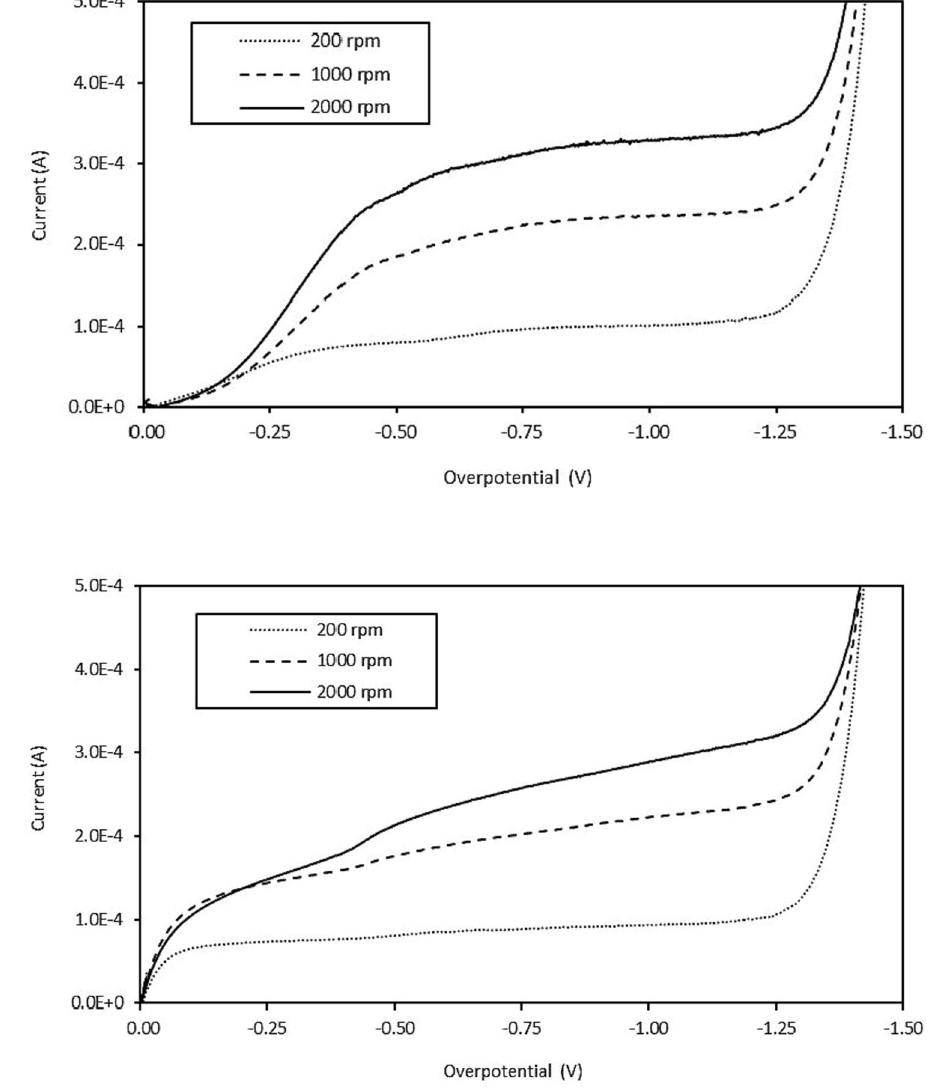
Fig. 11 IV curve for electrode of Pik-55